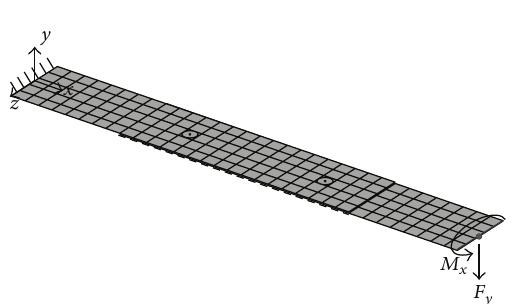
Figure 2: FE model of friction